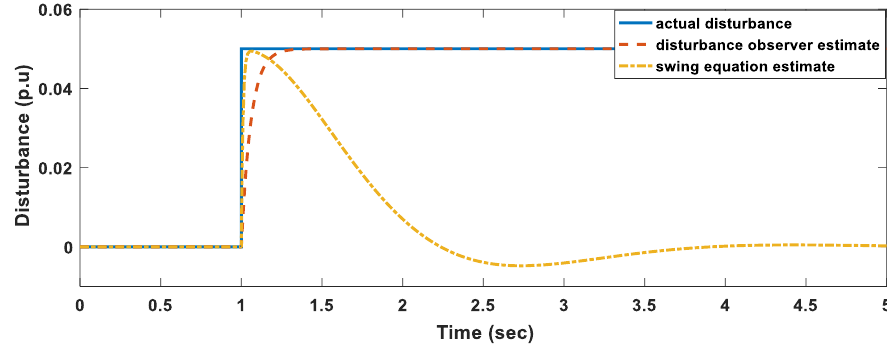
Figure 13. Scenario 2 disturbance observer vs swing equation estimation.